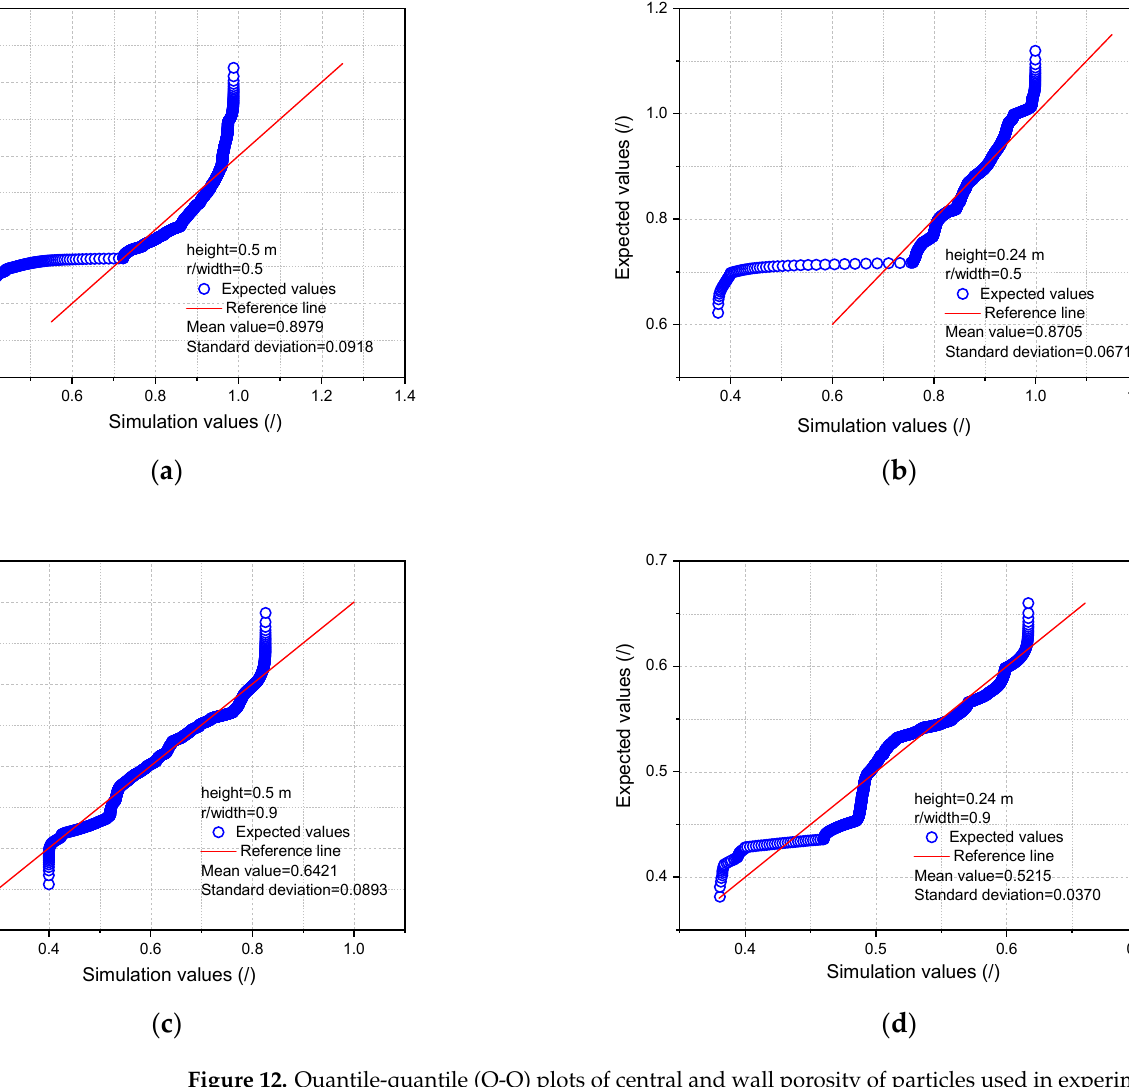
are approximately 1.5 Hz and 1.3 Hz, which are greater than those approximately 1.3 Hz and 0.3 Hz at the height of 0.24 m, indicating that the central fluctuations have the similar dominant frequencies, and the wall fluctuation at 0.5 m is approximately 3.0 times greater than that of 0.24 m. Each sharp peak denotes that the preliminary single larger bubble exists in the fluid-particle system. Two or more bubbles can be observed for experimental particle due to multi-peaks in central fluctuations, corresponding the approximately 4.5 Hz Figure 11. Quantile-quantile (Q-Q) plots of central and wall porosity of EG particles at the height of and 9.0 Hz. Multiple bubbles generate the breaking-up, smaller vortex of gas and particle 0.24 m and 0.5 m, r/Width = 0.5 and 0.9, ρ p = 800 kg/m 3 . ( a ) central distribution, 0.5 m; ( b ) central phases more easily, indicating that higher frequency is accompanied with smaller residence distribution, 0.24 m; ( c ) wall distribution, 0.5 m; ( d ) wall distribution, 0.24 m. time. The discrepancy in particle density leads to the variations of dominant frequency, and experimental particle is 3.0 times larger than that of ultralight particle in central fluctuations.